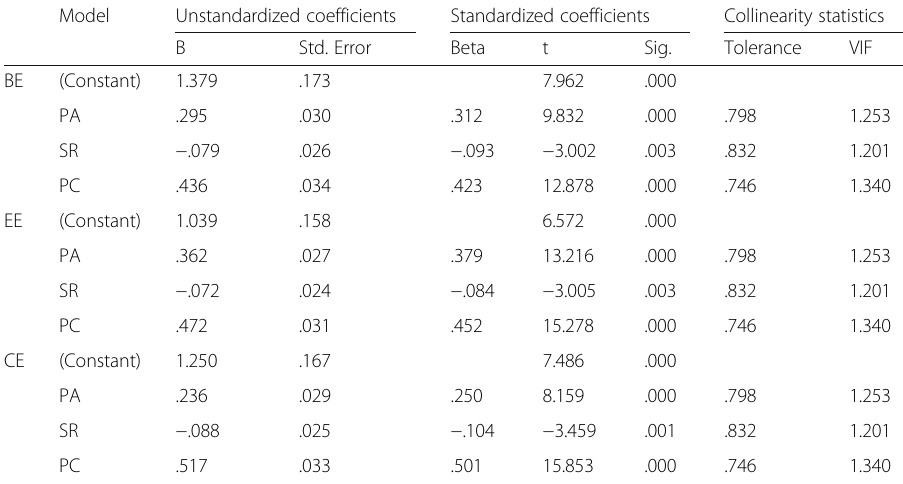
Table 5 Multiple regression analysis results of SDT components on engagement Model